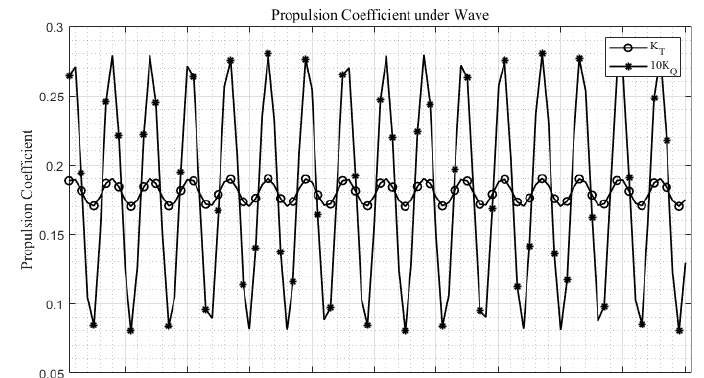
Figure 6. Torque and thrust coefficients under waves.